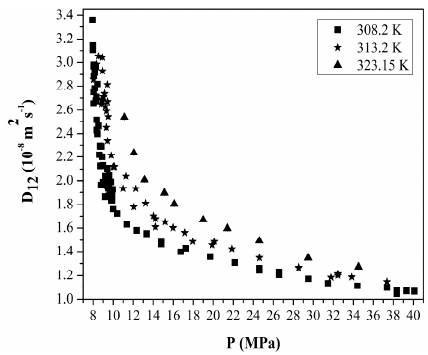
Figure 8. Binary diffusion coefficients of acetone in scCO 2 at infinite dilution obtained by curve fitting in the time domain (FTD) method vs. pressure at three different temperatures. Adopted with permissions from [59,60].